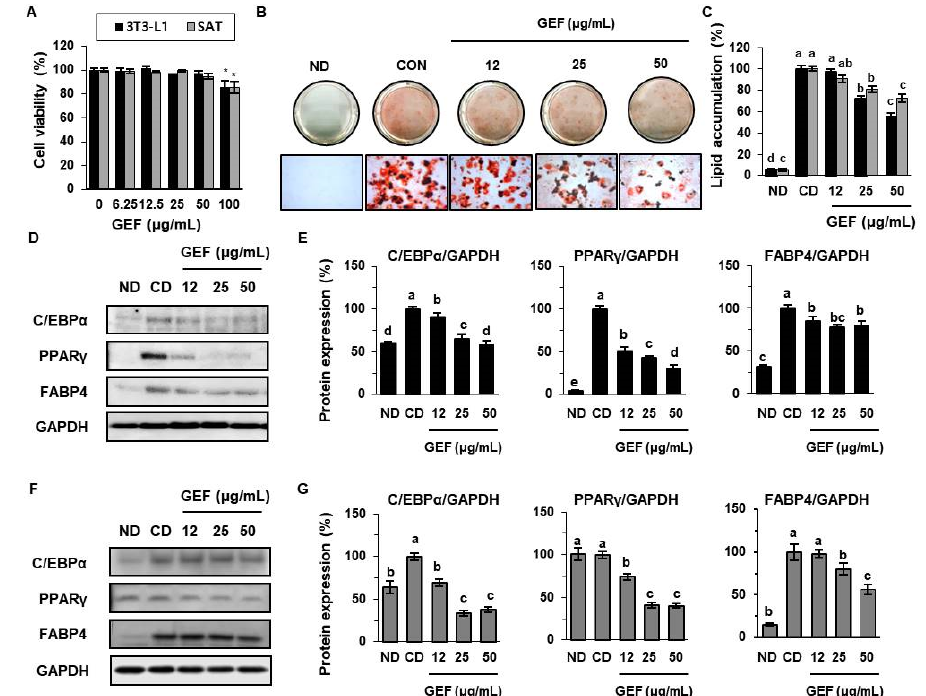
Figure 1. Effects of gintonin-enriched fraction (GEF) on lipid accumulation in 3T3-L1s and subcutaneous adipocytes (SATs). ( A ) Viability of 3T3-L1s and SATs treated with GEF for 24 h, determined using an MTT assay. ( B–C ) Photomicrographs and quantification of oil red O-stained adipocytes that had been treated with GEF during their 8 days of differentiation. ( D–E ) Expression of adipogenic proteins (CCAAT/enhancer-binding protein alpha (C/EBPα), peroxisome proliferator-activated receptor gamma (PPARγ), and fatty acid-binding protein 4 (FABP4)) in 3T3-L1s. ( F–G ) Expression of adipogenic proteins in SATs. Data are expressed as mean ± SD ( n = 4). Treatments with different letters were significantly different, p < 0.05 (a > b > c > d > e). CD, control of differentiation;